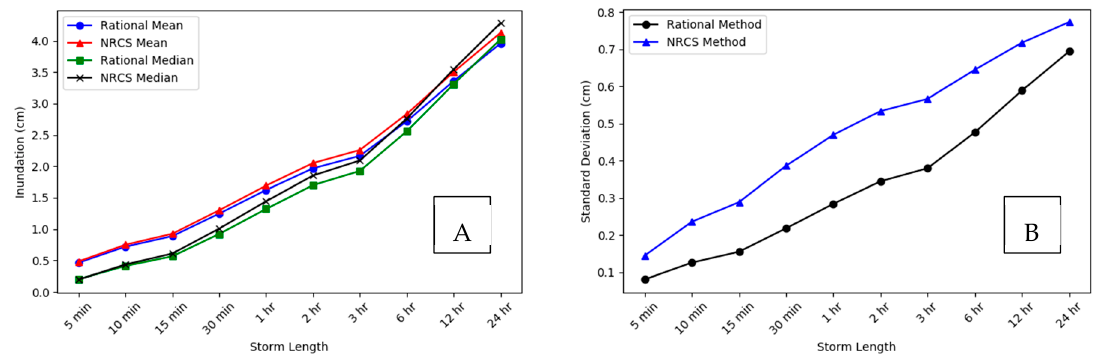
Figure 9. The mean and median runoff depths ( A ) and standard deviation ( B ) of all subbasins in Philadelphia, estimated by the NRCS and rational models for a 24-hour, 10-year storm.